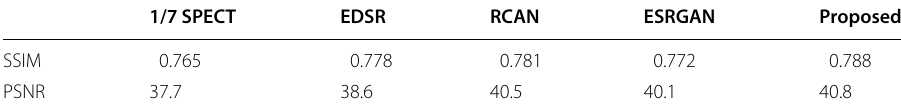
Table 1 Average SSIM and PSNR comparison for different methods 1/7